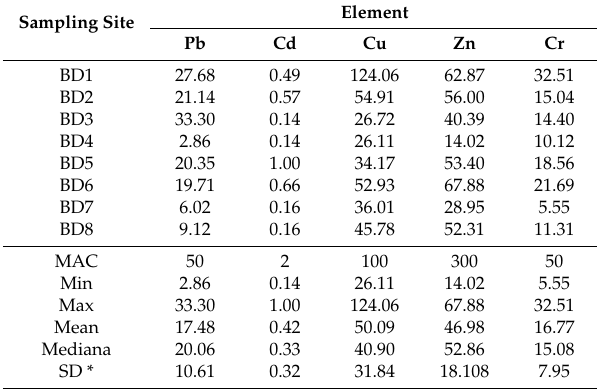
Table 3. Total contents and descriptive statistics of elements in Budva (BD) urban parks soil samples, this study (mg ¨ kg ´ 1